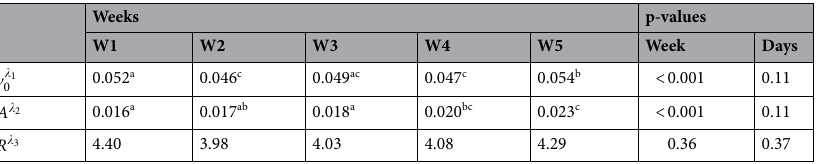
(cid:31) 1 , v (cid:31) 2 R (cid:31) 3 are 0 and